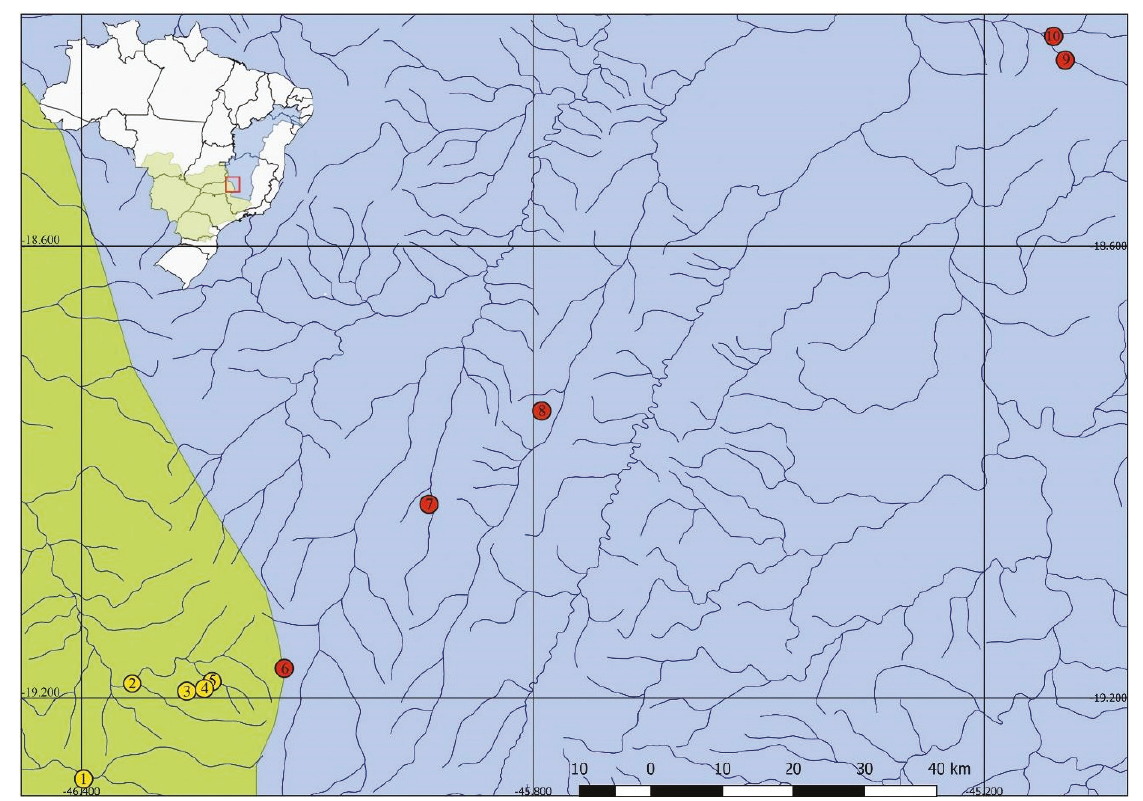
Figure 1: Sampling sites of specimens of this study. The locations numbered from 1 to 5 belong to the Parana´ıba River basin; locations 6 to 10 belong to S˜ao FranciscoRiver Basin. 1: S˜ao Jo˜ao river; 2: Parana´ıba River; 3: Lava P´es stream; 4: Parque de Exposic¸˜oes stream; 5: ´Agua Grande stream; 6: Abaet´e river; 7: Tiros stream; 8; Borrachudo river; 9: Boi river; 10: Vereda Grande